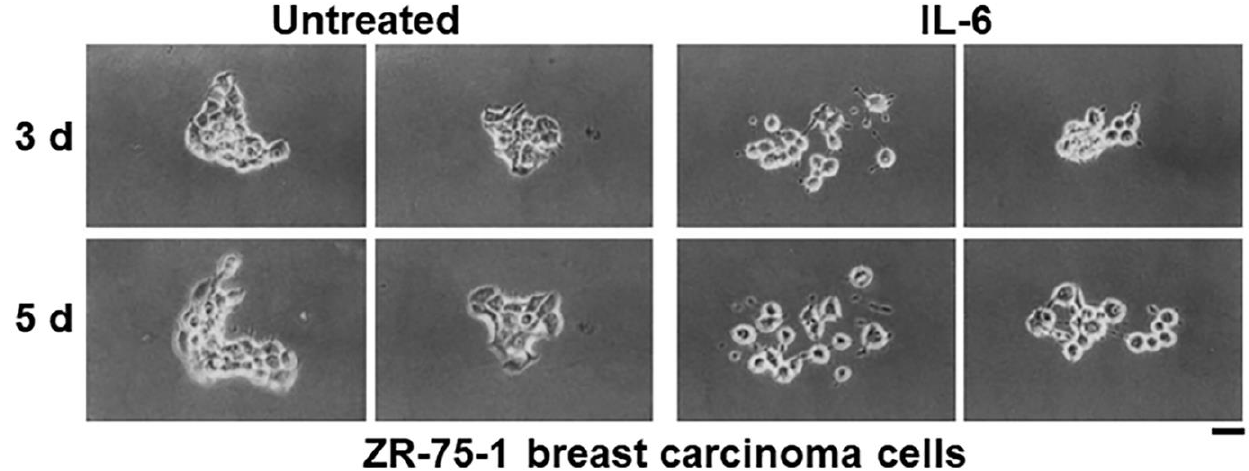
Figure 2. IL-6 increases motility of ZR-75-1 breast carcinoma cells. ZR-75-1 cells plated at a low density (42 cells/cm 2 in T-25 flasks) were either left untreated or exposed to rIL-6 (15 ng/mL). Live cell images were of the same colonies at 3 or 5 days after plating. Two representative colonies under each experimental condition (at 3 d and 5 d) are illustrated. Scale bar = 30 µm. Adapted from Tamm et al., 1989 [3].